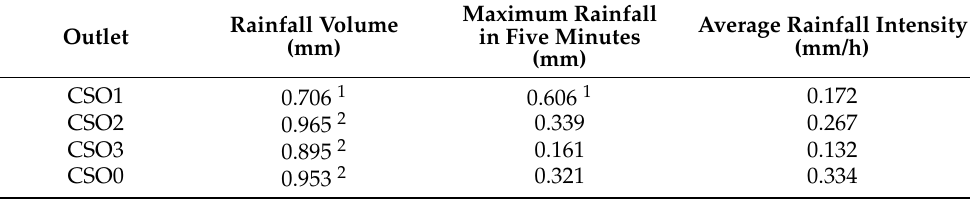
Table 4. Correlation coefficient between overflow and